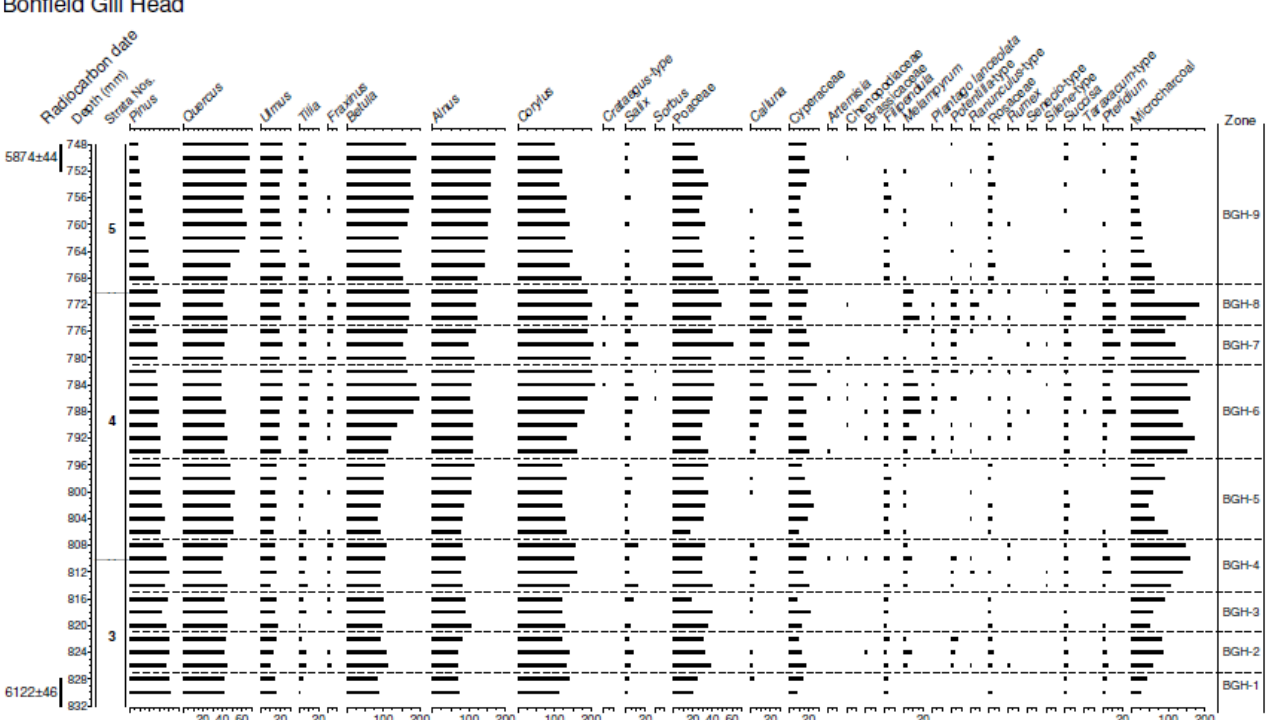
Figure 5. Selected taxa pollen diagram through a Mesolithic age disturbance phase at Bonfield Gill Head. Frequencies are calculated as percentages of total tree pollen, which comprises Pinus to Fraxinus in the diagram. Betula and Alnus are excluded because of local superabundance at this site.